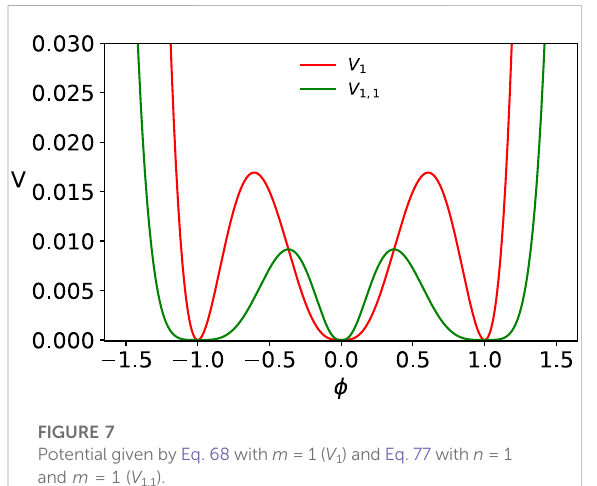
FIGURE 8 Potential given by Eq. 68 with m = 2 ( V 2 ) and Eq. 77 with n = 2 and m = 2 ( V 2,2